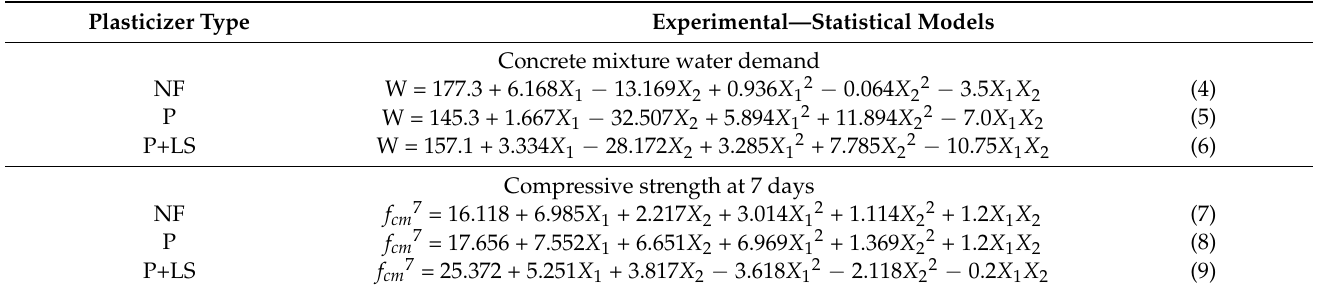
Table 5. Experimental and statistical models of water demand and strength of concrete on low-clinker slag Portland